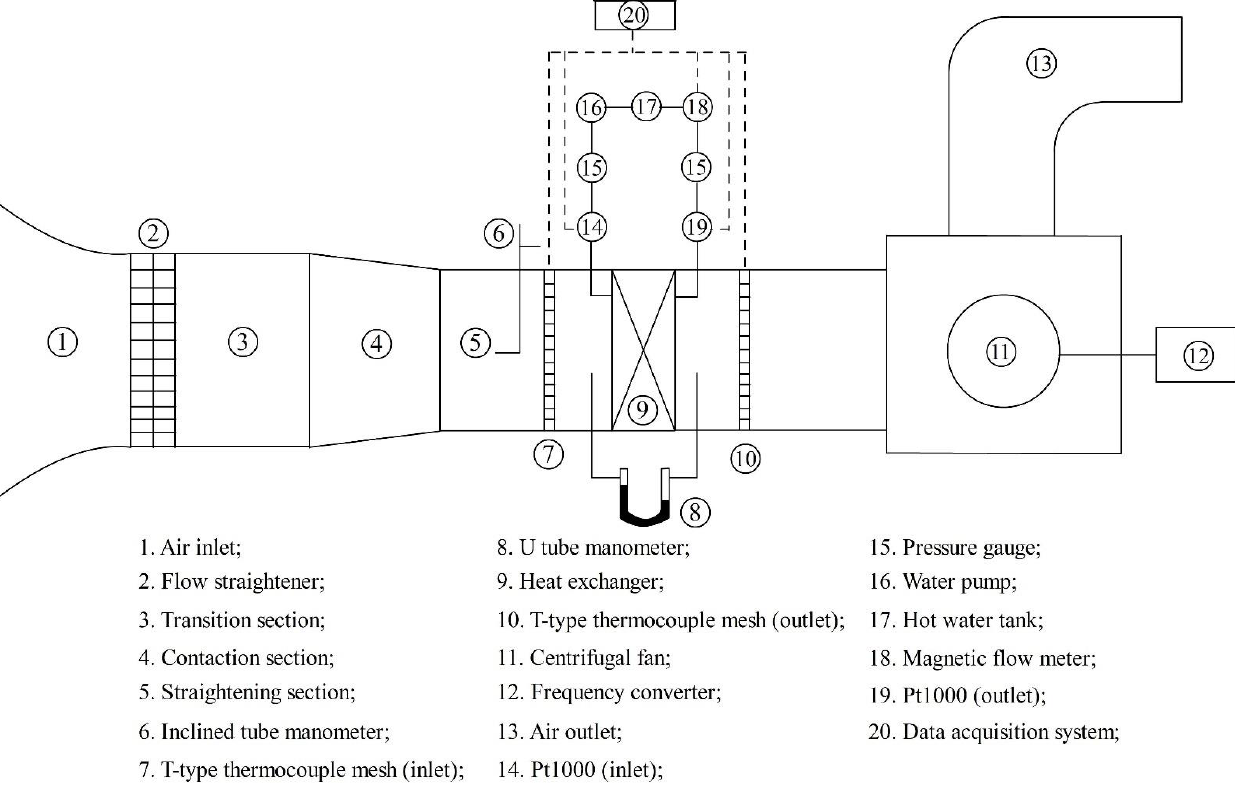
Figure 3. Schematic diagram of test table [18].